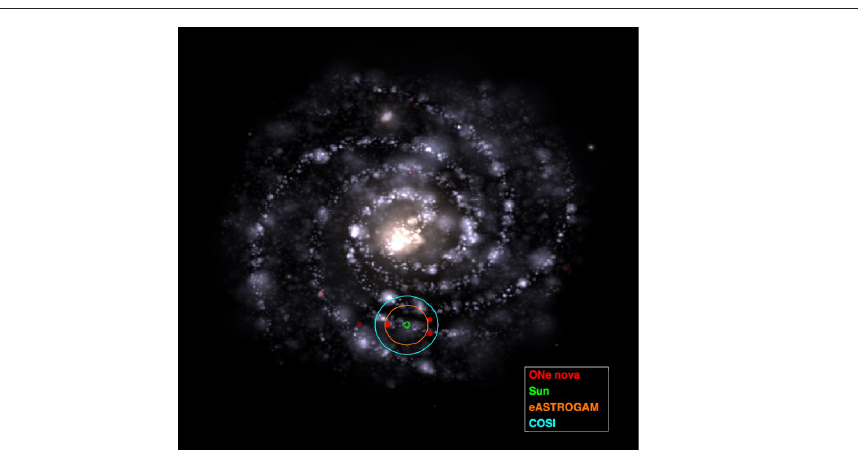
Figure 4. Map of the Milky Way with the expected flux of 22 Na, represented by the red dots, from the ONe novae observed for the last 60 years. Circles represent the limit distance of COSI and eASTROGAM to detect γ -rays from 22 Na. The former should detect such emission once every 20